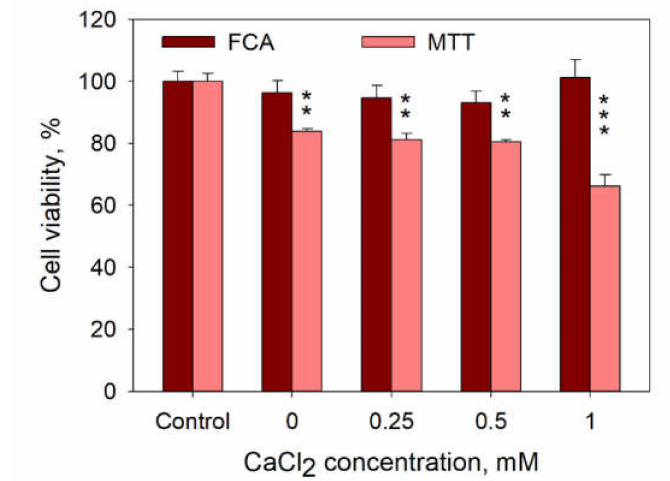
Figure10. Cellviabilityaftercelltreatmentusing1HVpulseata100- µ spulsedurationevaluatedbyflow cytometry assay (FCA, dark bars) and MTT (light bars) in dependence of the CaCl 2 concentration in the medium. Symbols denote statistical di ff erences between the control (untreated cells) and electroporation groups at 0, 0.25, 0.5, 1 mM CaCl 2 concentration. Two symbols denote p < 0.01, three symbols— p < 0.001. The error bars represent the mean ± standard error of mean of n = 6 experimental